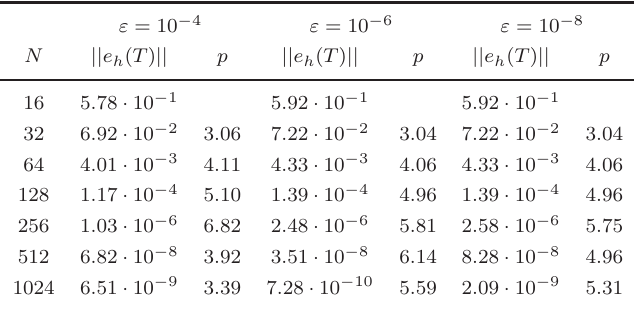
Table 1. Numerical results for method of order p = q = 4. ε = 10 −